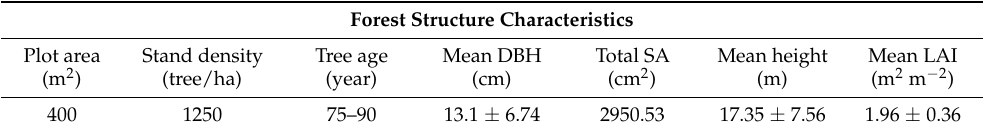
Table 1. Detailed information of forest structure in the Larix gmelinii